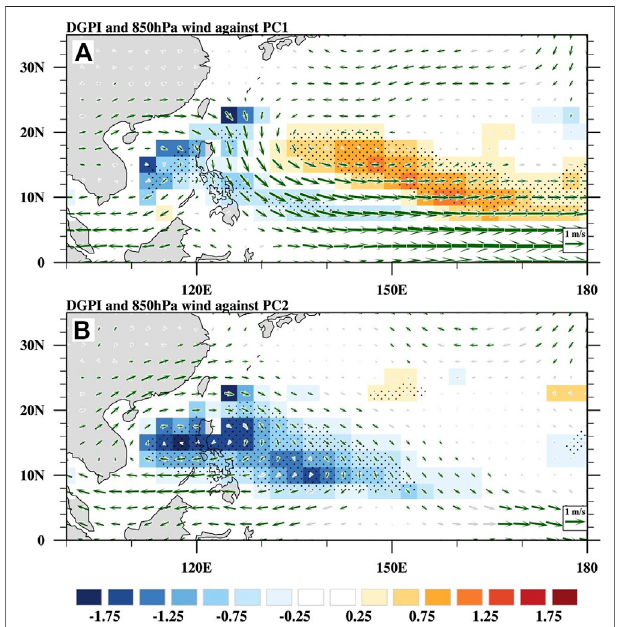
FIGURE 4 | Regressed dynamic genesis potential index (shading) and 850 hPa wind (vectors, m s − 1 ) anomalies against the (A) PC1 and (B) PC2 during 1965 – 2018. Dots (green vectors) denote the anomalous DGPI (steering fl ows) that are signi fi cant at 90% con fi dence level.